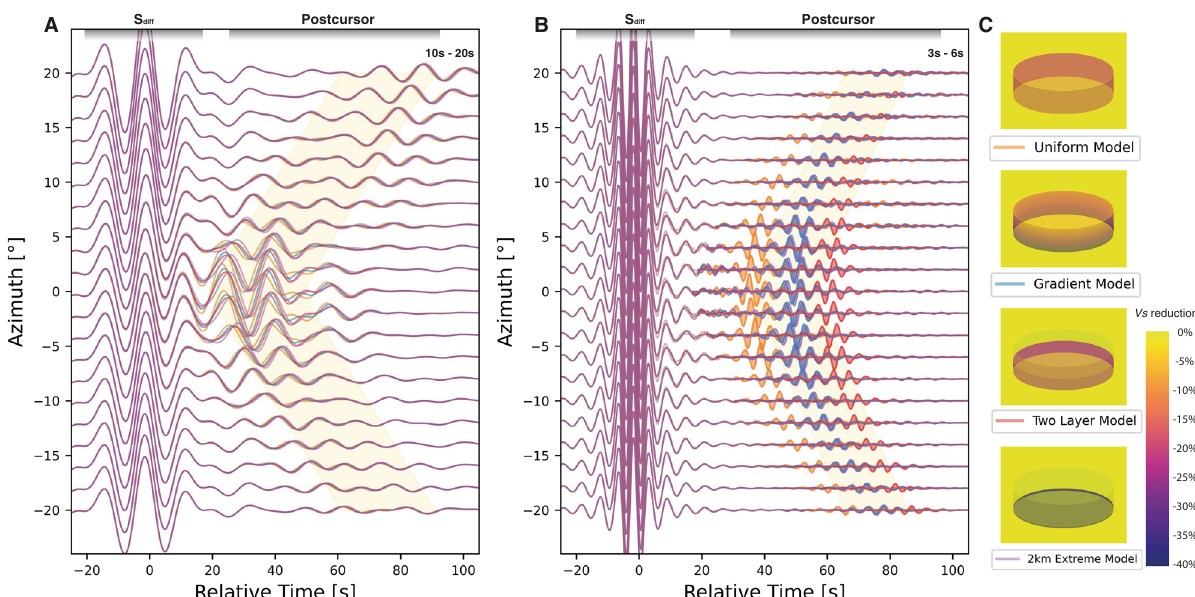
Fig. 4 3D Synthetic waveforms of four different ultra-low velocity zone (ULVZ) models computed down to period of 3 s. Synthetics are made for a uniform ULVZ model of 20 km with − 20% dln V S (orange), a two-layer ULVZ model of 10 km − 10% dln V S layer on top plus a 10 km − 30% dln V S layer at bottom (red), a 20 km gradient model changing gradually with ULVZ height from − 10% to − 30% dln V S (blue), and an extreme 2 km − 40% dln V S basal layer (purple) within a ULVZ of 20 km thickness with − 20% dln V S . Synthetic waveforms fi ltered into the ( A ) long-period range (10 – 20 s) and ( B ) short- period range (3 – 6 s). The source depth and the distance to the ULVZ are the same as for Event 20100320. The ULVZ model is located at 0° azimuth and 39.7° distance from the source. The synthetics are shown for epicentral distances of 105° as a function of azimuth. The time axis is aligned by the S diff travel time predicted by PREM 49 . The waveforms of the short-period postcursor are fi lled to emphasize them. Note that the gradient model (blue) and 2 km extreme basal model (purple) nearly overlap. The faded yellow shading indicates the time delay ranges for the long- and short-period postcursors as observed in the real data. (C) Cartoons of four different ULVZ models tested in the synthetics.